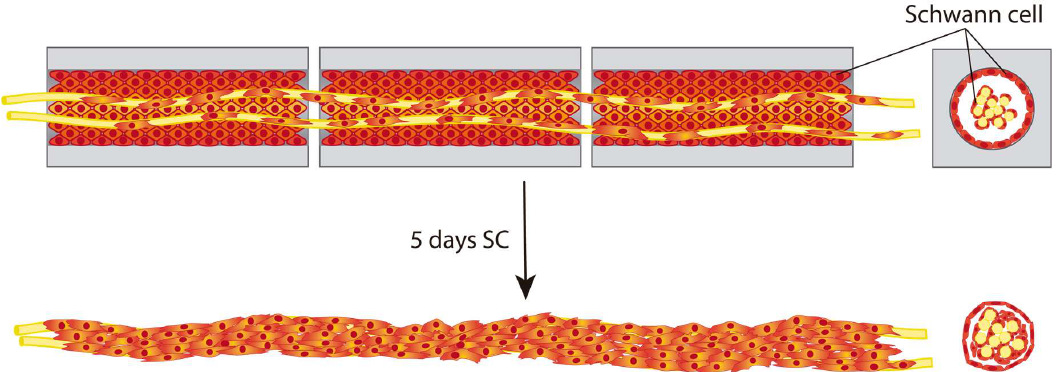
Figure 2. Schematic view of the generation of the ‘neural cord’. Longitudinal and transversal schematic view of ‘neural cord’ after 5 days of SC culture and elimination of the HA conduits, obtaining a live hybrid pseudonerve in vitro for a possible